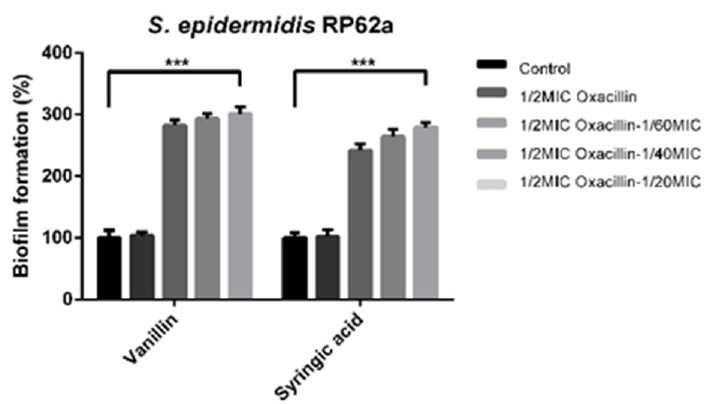
Figure 1. The effect of vanillin and syringic acid in combination with oxacillin on biofilm formation of S. epidermidis RP62a (*** p < 0.001).